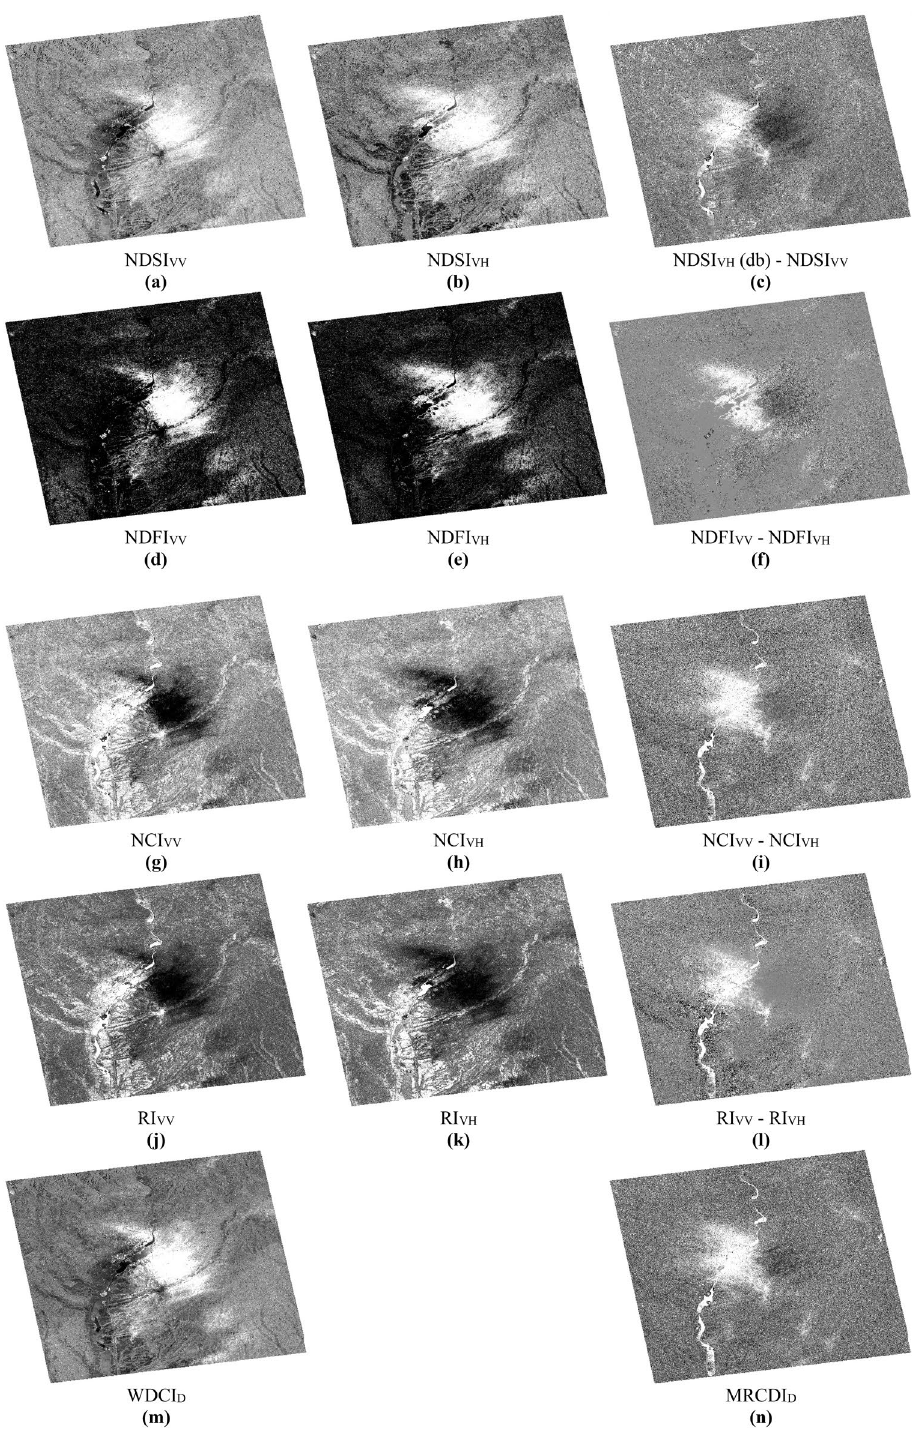
Figure 17. Images showing the results of all the indices tested as well as those used in this study; ( a – c ) NDSI index with its two components and their subtraction; ( d – f ) NDFI index with its two components and their subtraction; ( g – i ) NCI index with its two components and their subtraction; ( j – l ) index RI with its components and their subtraction; ( m ) WDCI D index; ( n ) MRCDI D